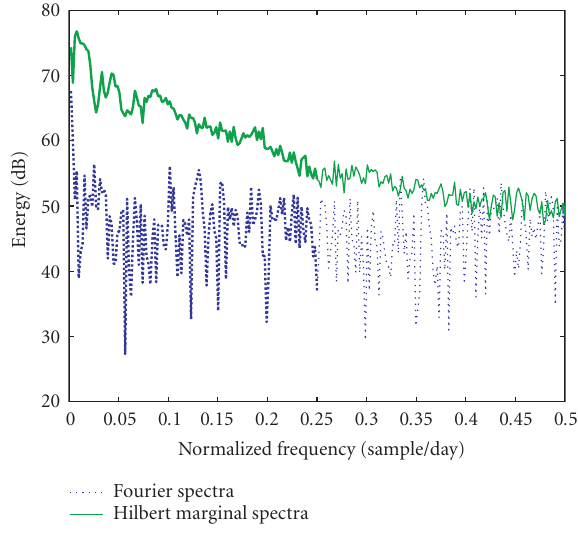
Figure 3.5. Comparison of marginal Hilbert spectrum with Fourier